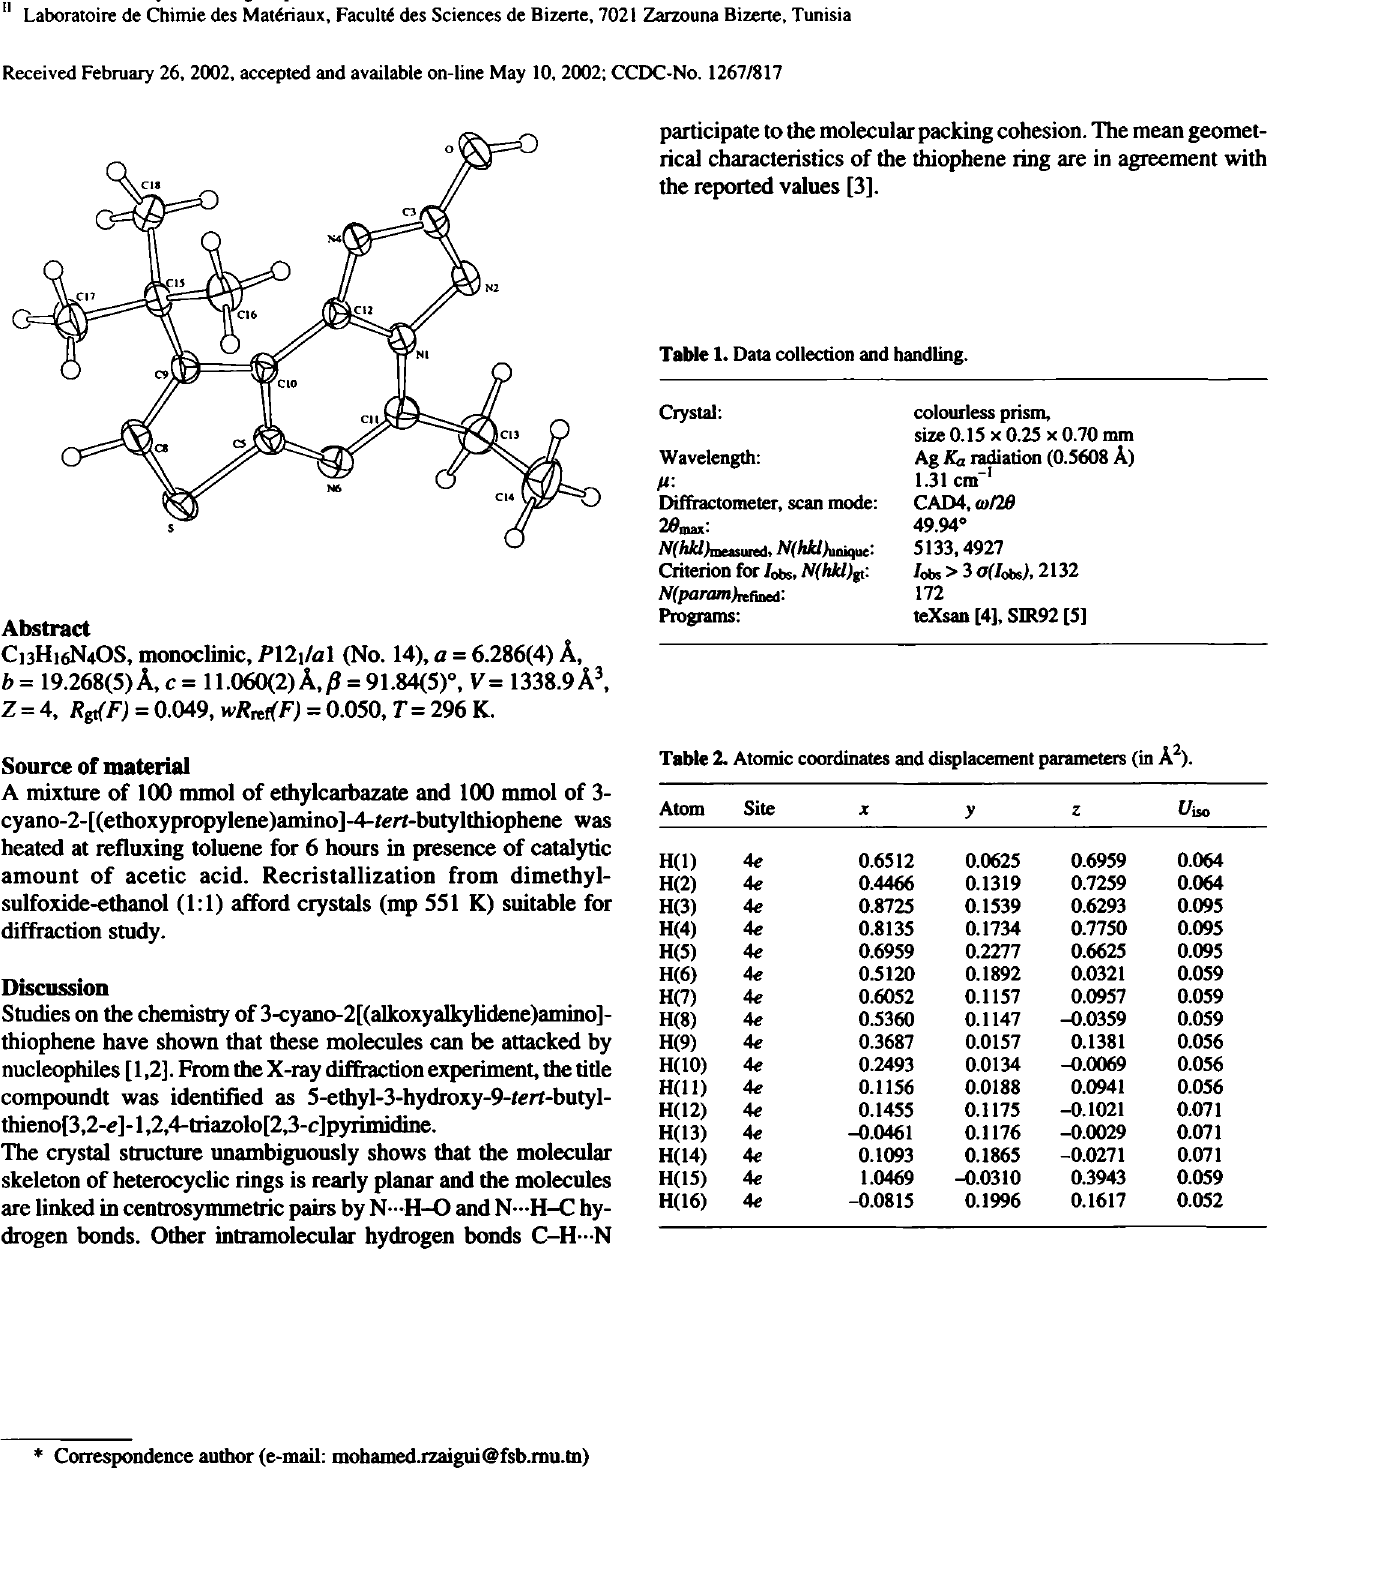
Table 1. Data collection and handling.